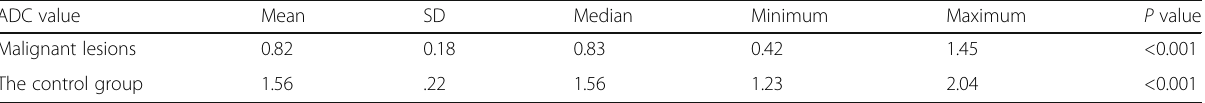
Table 5 The ADC values in malignant cervical lesions and the control group ADC value